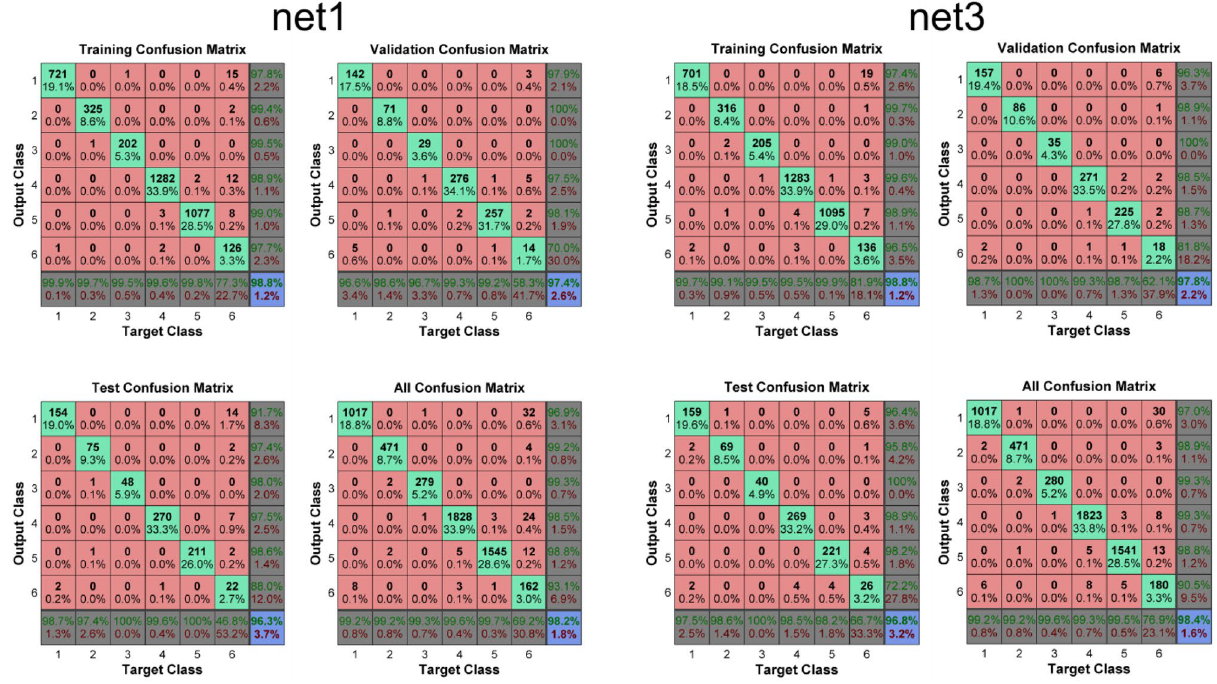
Figure 7. Confusion matrices of the different two-layer feedforward networks. The class number of the different behavioral categories can be seen in Fig. 2.